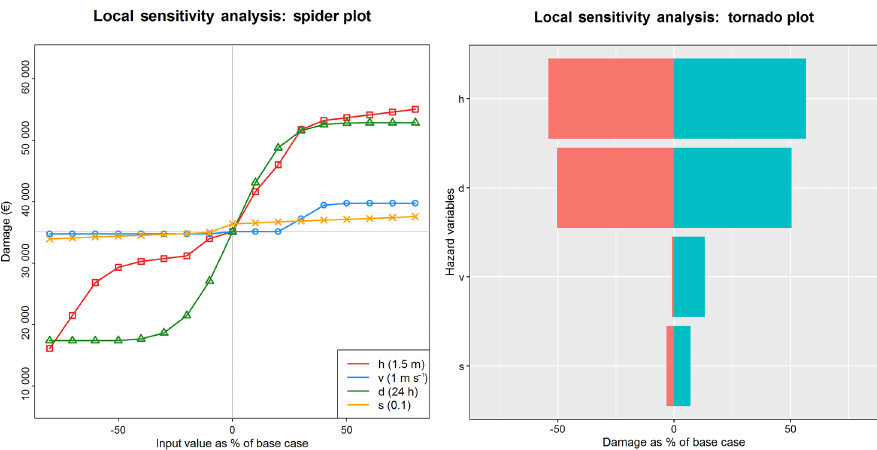
Figure 5. Results of the local sensitivity analysis in case of low velocity, long duration